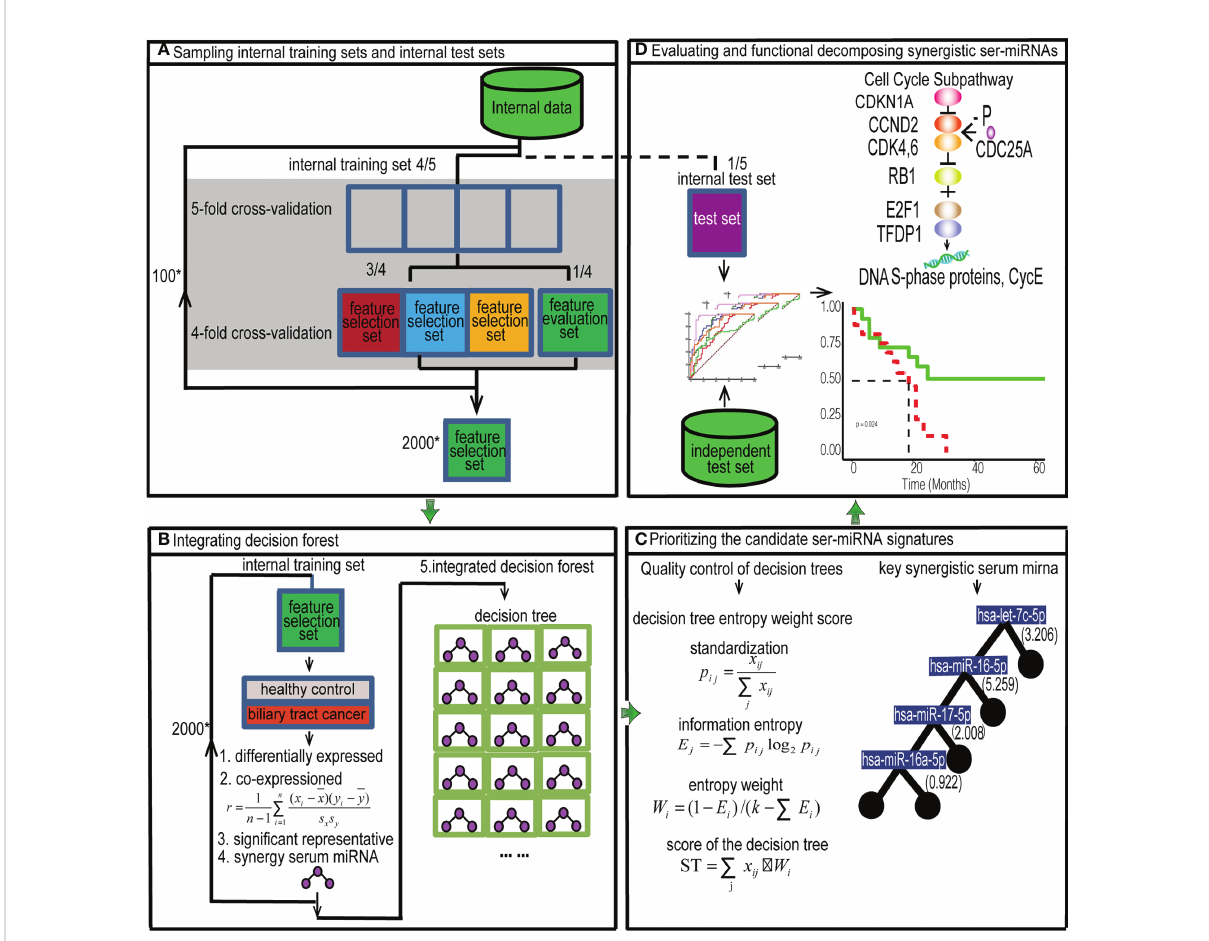
FIGURE 1 Flow chart. Prioritizing synergistic circulating miRNAs for the early diagnosis of BTC by GOADF. (A) The internal data set was divided into the feature selection dataset, feature evaluation dataset and internal test set and 2,000 feature selection sets were produced by sampling technology. (B) In internal training set, every feature selection set produced a decision tree. The 2,000 decision trees were integrated into decision forest. (C) We fi ltered out the trees with low quality and sorted the decision tree by ST to identify the key synergistic ser-miRNAs. (D) The synergistic ser-miRNAs were evaluated in the internal and independent test sets. The function of synergistic ser-miRNAs was to decompose by KEGG sub-pathway identi fi cation and GO enrichment. ” * ” means multiple